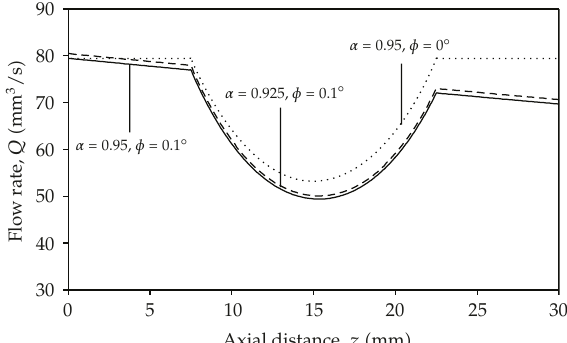
Figure 5: Variation of the rate of flow with axial distance for di ff erent values of α and φ with t (cid:7) 0.5, τ m (cid:7) 0.1 a , τ y (cid:7) 0.1, μ H (cid:7) 0.035, and μ N (cid:7) 0.3 μ H .